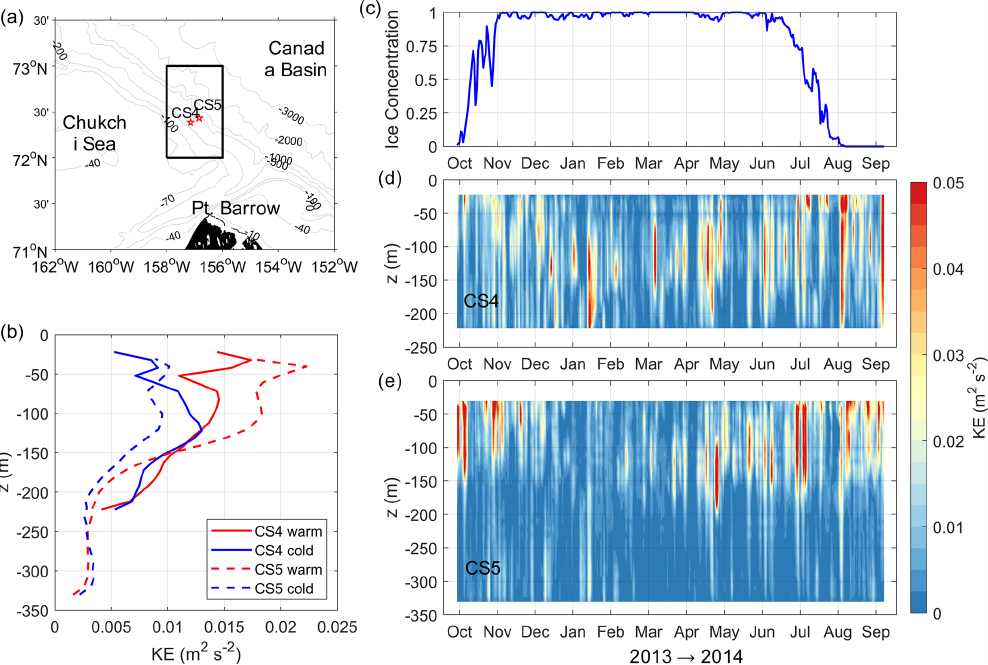
Figure A1. (a) Locations of the BOEM Chukchi slope moorings CS4 and CS5. The black box outlines the region for calculating the ice concentration. (b) Vertical profiles of the KE averaged over warm (October and November 2013 and July to September 2014) and cold (December 2013 to June 2014) months at moorings CS4 and CS5. The warm (cold) month is defined as the month with the mean ice concentration less (larger) than 0.9. (c) Time series of the area-mean ice concentration from October 2013 to September 2014. (d, e) Time– depth plots of the KE at moorings CS4 and